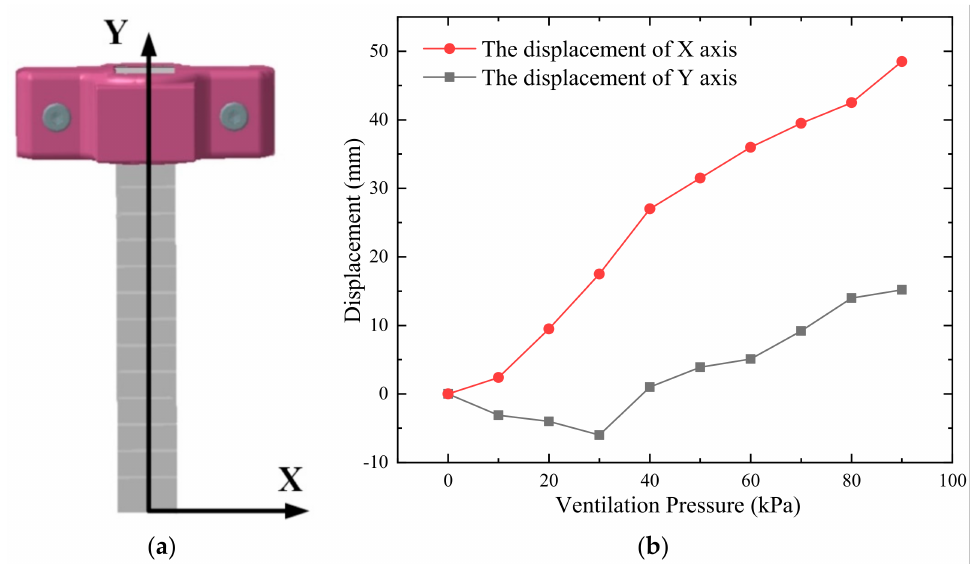
Figure 14. ( a ) X − Y plane coordinate system virtual partition; ( b ) displacement of the soft manipulator along the x - and y -axes.